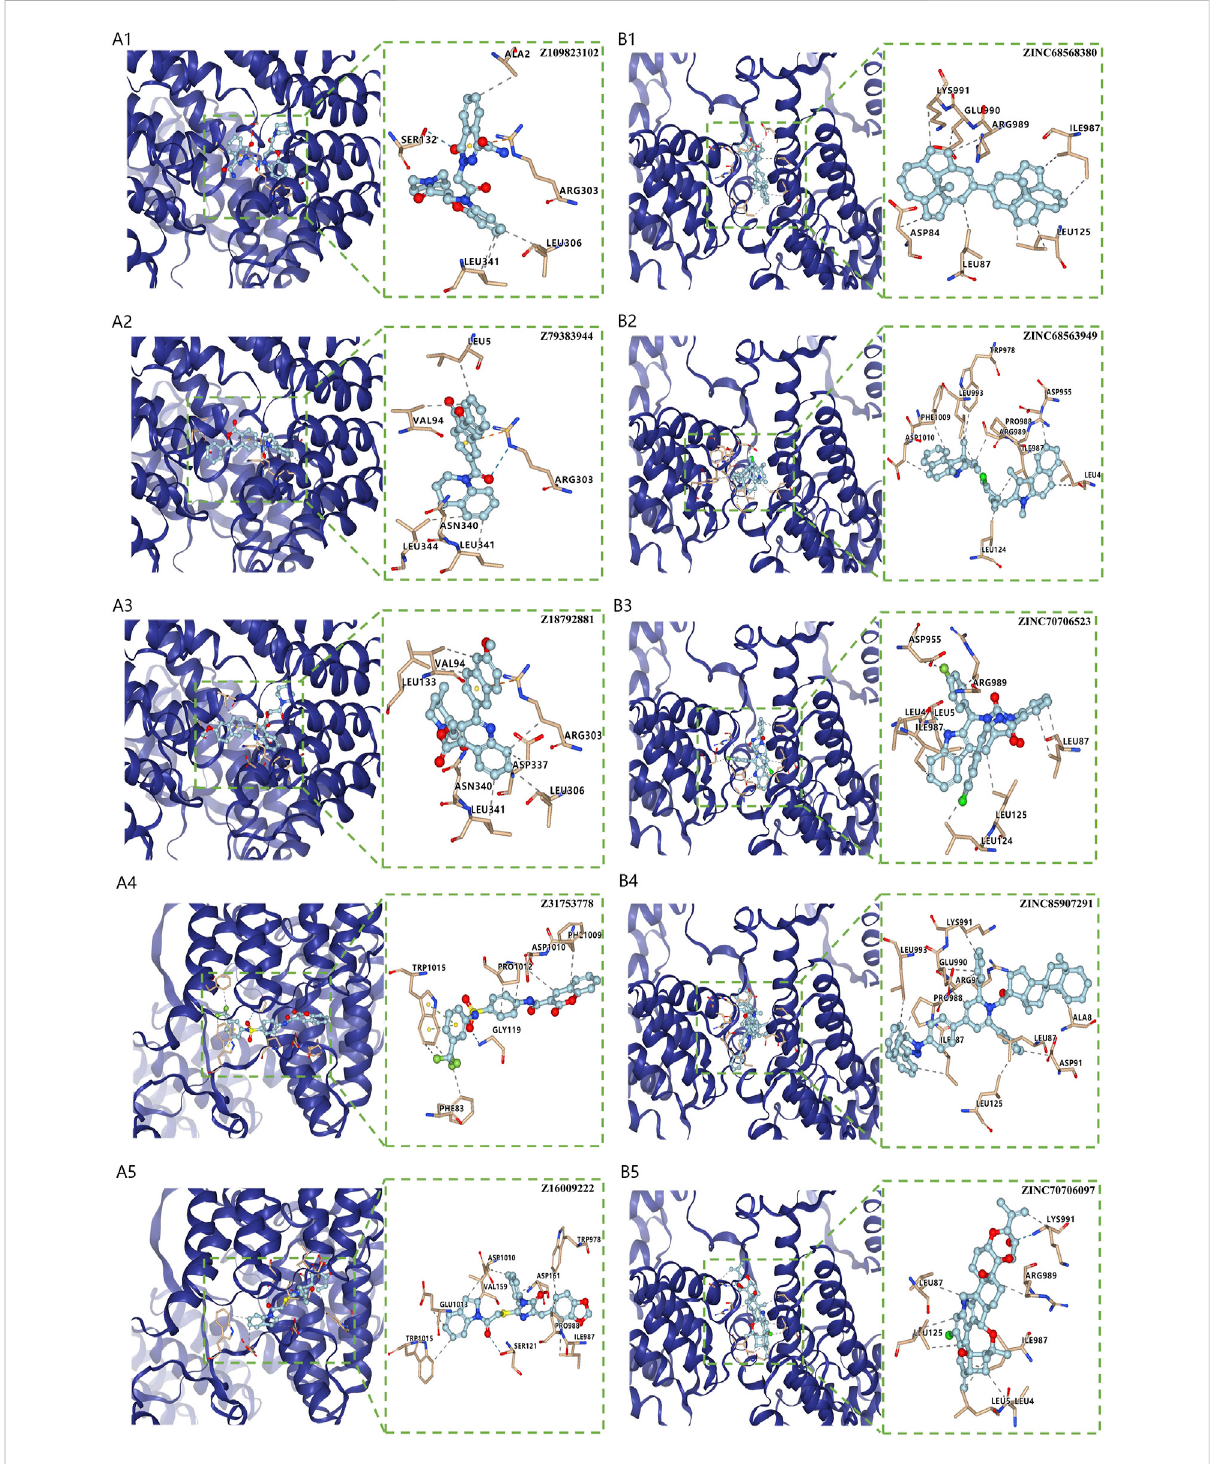
FIGURE 11 VirtualScreeningforPotentialDrugsTargetingLRPPRC. (A) Thetop fi vedockedcompounds(Z109823102,Z79383944,Z18792881,Z31753778, Z16009222) from Enamine HTS potentially targeting LRPPRC. Interaction type between each compound and LRPPRC: Z109823102 (hydrophobic interaction, hydrogen bond, π -cation interaction), Z79383944 (hydrophobic interaction, hydrogen bond, π -cation interaction), Z18792881 (hydrophobic interaction, π -cation interaction), Z31753778 (hydrophobic interaction, hydrogen bond, π - π stacking), Z16009222 (hydrophobic interaction, hydrogen bond). (B) The top fi ve docked natural products (ZINC68568380, ZINC68563949, ZINC70706523, ZINC85907291, ZINC70706097) from ZINC potentially targeting LRPPRC. Interaction type between each product and LRPPRC: ZINC68568380 (hydrophobic interaction), ZINC68563949 (hydrophobic interaction), ZINC70706523 (hydrophobic interaction, hydrogen bond), ZINC85907291 (hydrophobic interaction), ZINC70706097 (hydrophobic interaction, hydrogen